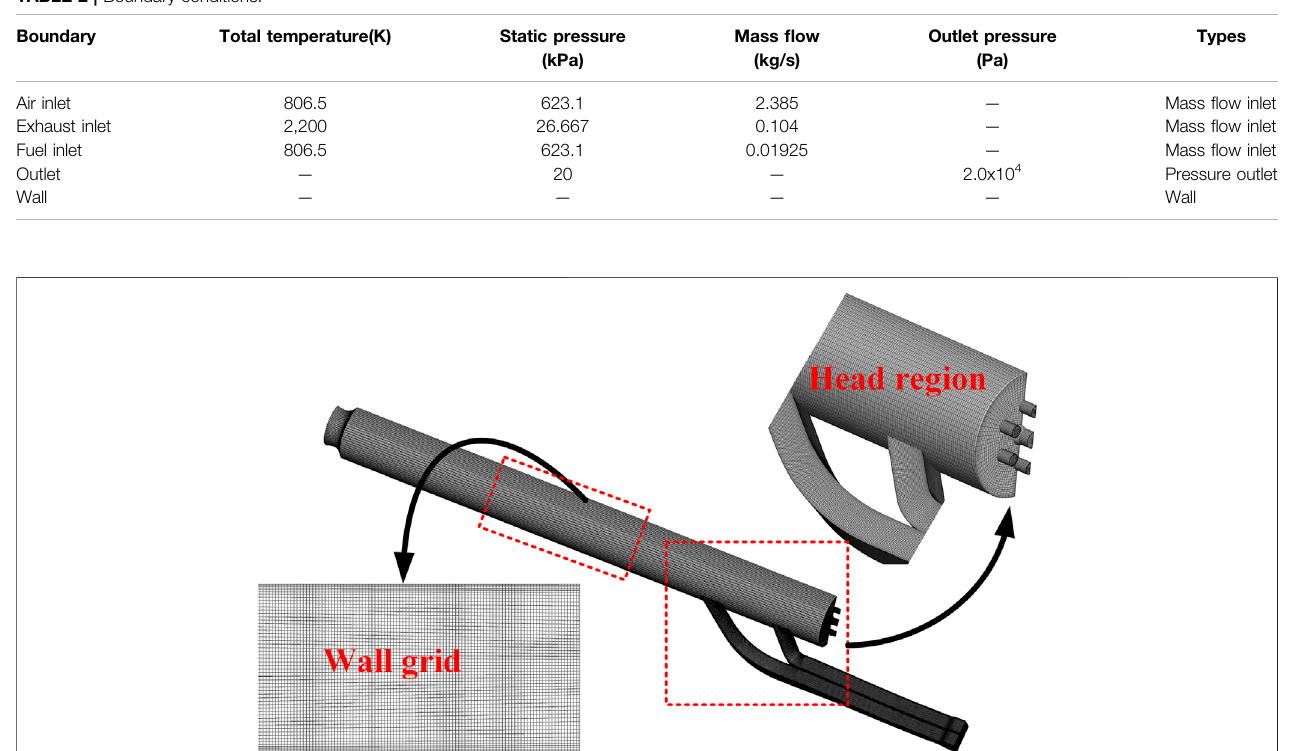
TABLE 2 | Boundary conditions.